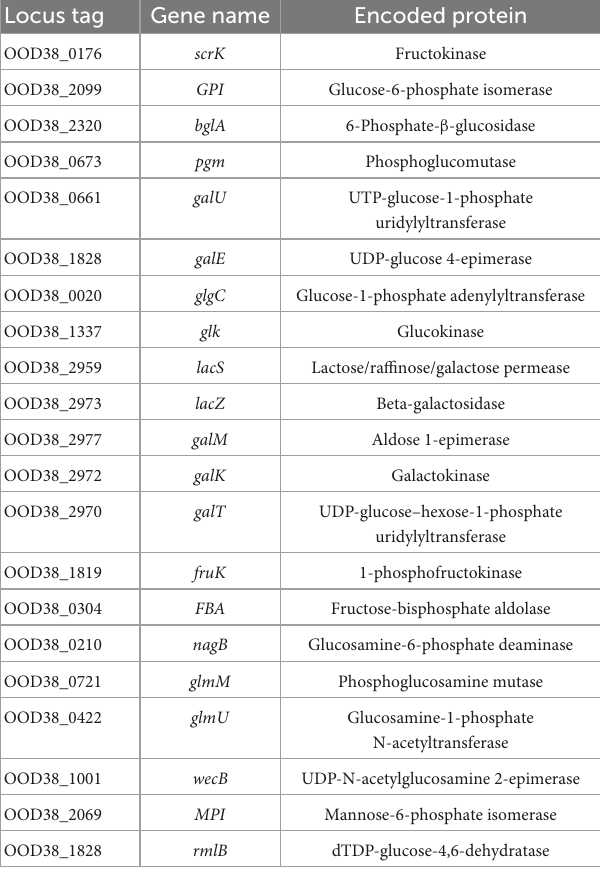
TABLE 3 Key enzymes of the nucleotide sugar biosynthesis process of Lp. plantarum MC5 annotated in the KEGG database. Locus